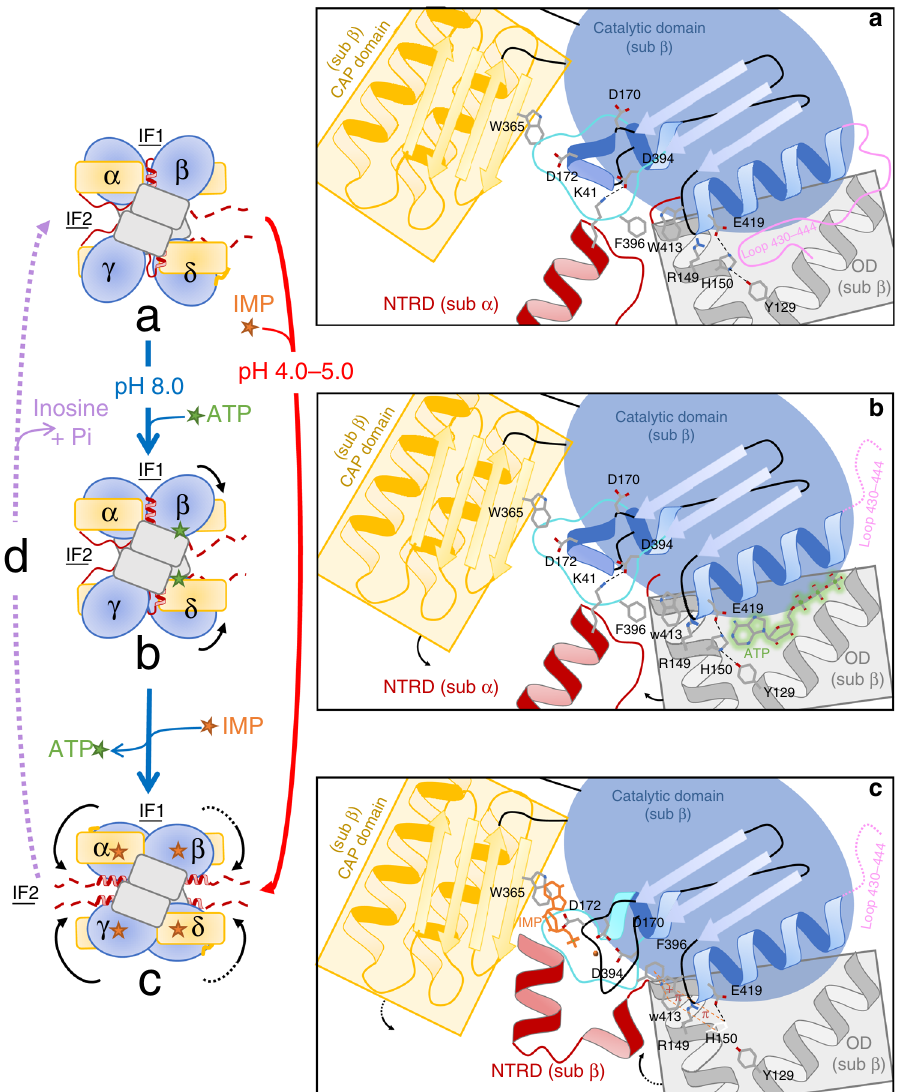
Fig. 6 Model illustrating the catalytic mechanism of Pf ISN1. In the fi rst step 1 ( a Pf ISN1-Apo), helix α 8 carrying one of the catalytic aspartates (D172), occupies the binding site of the phosphate moiety and Mg 2 + and K41 from subunits α and γ NTRD form salt bridges with D394 from subunits β and δ , respectively. In a second step and at pH 8.0: ATP occupies only two of the four effector sites in the tetramer (subunits β and δ ) ( b ) and induce a closure of these subunits upon ATP binding, thereby activating the enzyme after departure of Loop L430-Q444 . In this conformation, the base moiety of ATP forms a π - stacking with H150 which slightly turns and is stabilizes via hydrogen bond and salt bridge, respectively, with Y129 and E419. ( c ) Once activated and in a third step, the enzyme can bind IMP and Mg 2 + . This binding induces both reorganization of helix α 8 and Segment D394-F407 . As a consequence, F396 fl ips engendering long-distance stacking with W413, R149 and H150. This latter slightly rotates, breaks the hydrogen bond with Y129, causing departure of ATP. Closure of the enzyme induces correct accommodation of IMP by the Cap domain and forces the four NTRDs to relocate at interface 2. At pH 4.0 – 5.0: ATP is not an allosteric activator. IMP can bind to the four subunits allowing the enzyme to go directly from step 1 ( a ) to step 3 ( c ). Common for all pH values: step 4 ( d ) Return to the initial apo conformation including Loop L430-Q444 returning in the effector binding sites and release of inosine and P i into the medium. sub subunit, IF interface; black arrows indicate global movement of domains. colour code used is as in other fi